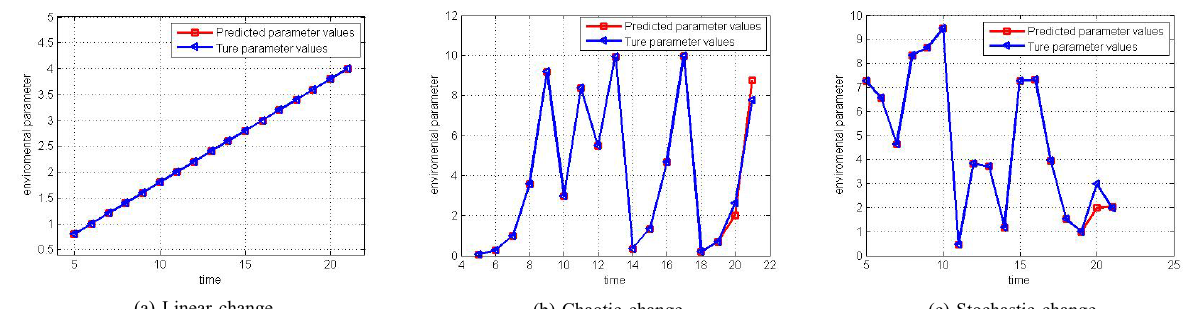
Fig. 2 The dynamic environmental parameters